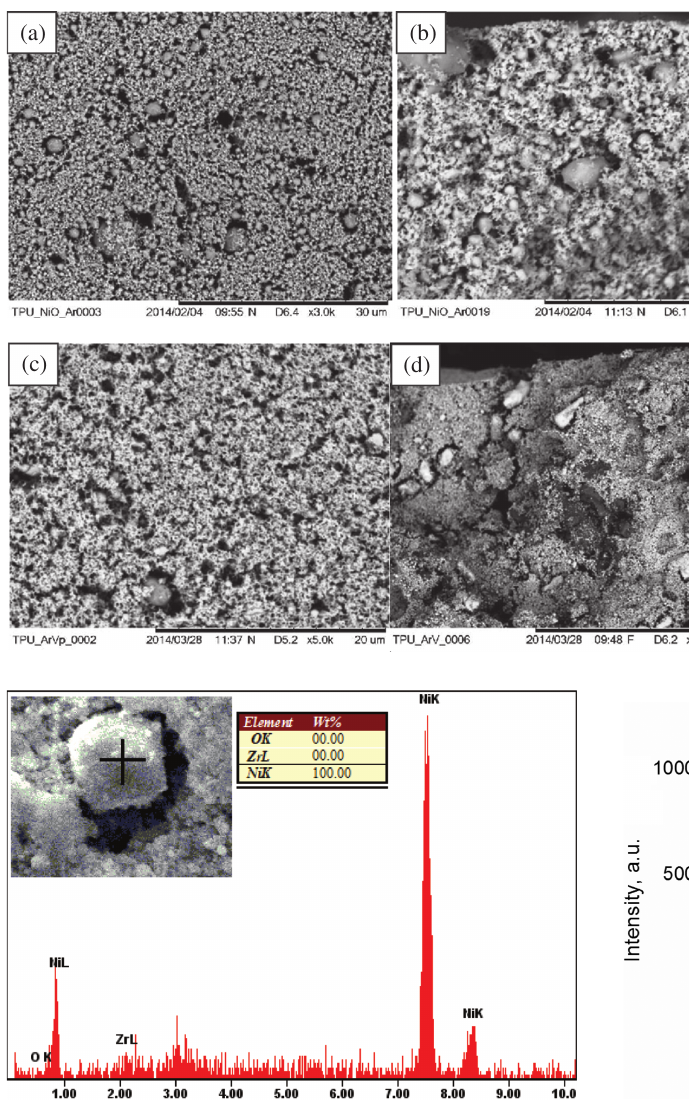
Figure 4: X-ray diffractograms: 1 – NiO/YSZ powder mixture, 2 – NiO/YSZ layer fabricated by spark plasma sintering in Ar at 1,100°C for 1 min (pressure is 10 MPa).